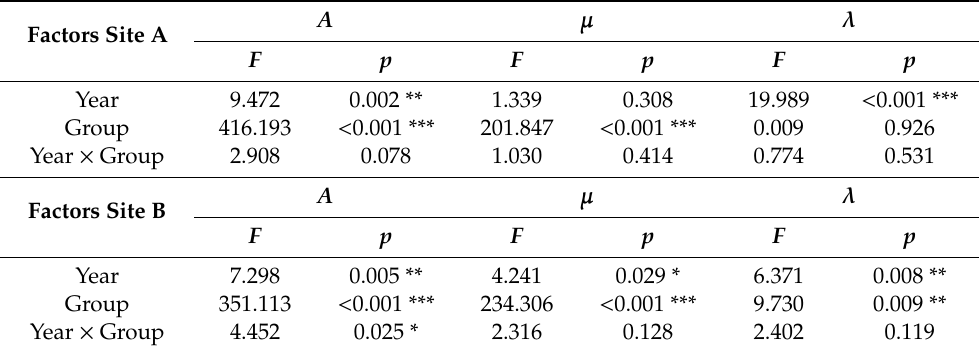
Table 3. Two-way analysis of variance (ANOVA) of the e ff ects of tree group and the inter-annual di ff erences of the growth and parameters A , µ , and λ .